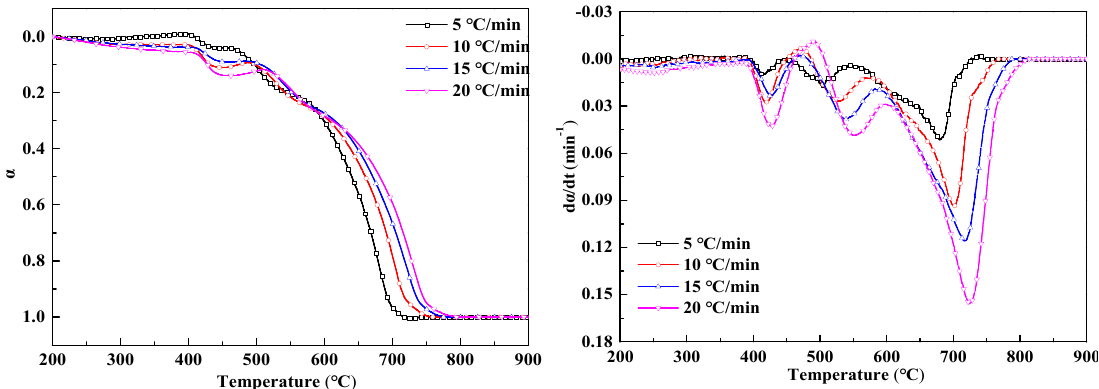
Figure 10. Fractional conversion and reaction rate-conversion curves of the sintered mixture at different heating rates.